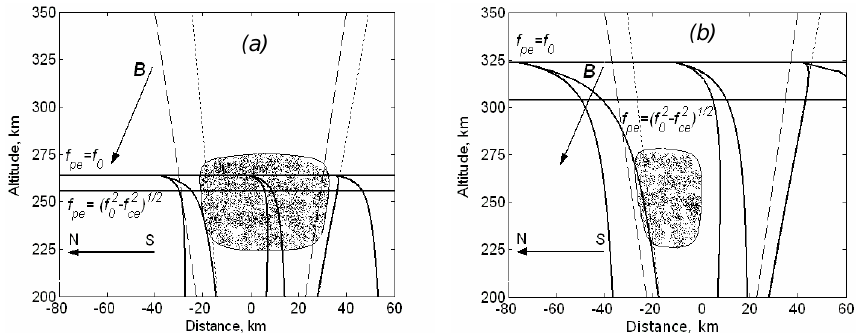
Fig. 5. Ray tracing for the pump wave with f 0 = 4 . 3MHz in the magnetic meridian plane for ionograms, obtained at 21:09 LT (a) and 22:48 (b) . Dashed and dotted lines show the imager field of view and the pump beam borders, respectively. Magnetic field direction is shown by arrows, schematic blobs in the panels correspond to the airglow patches obtained at 21:11:55 LT (panel a) and 22:47:55 LT (panel b), Figure 5 for the paper by Grach et al. “On the location and structure…”